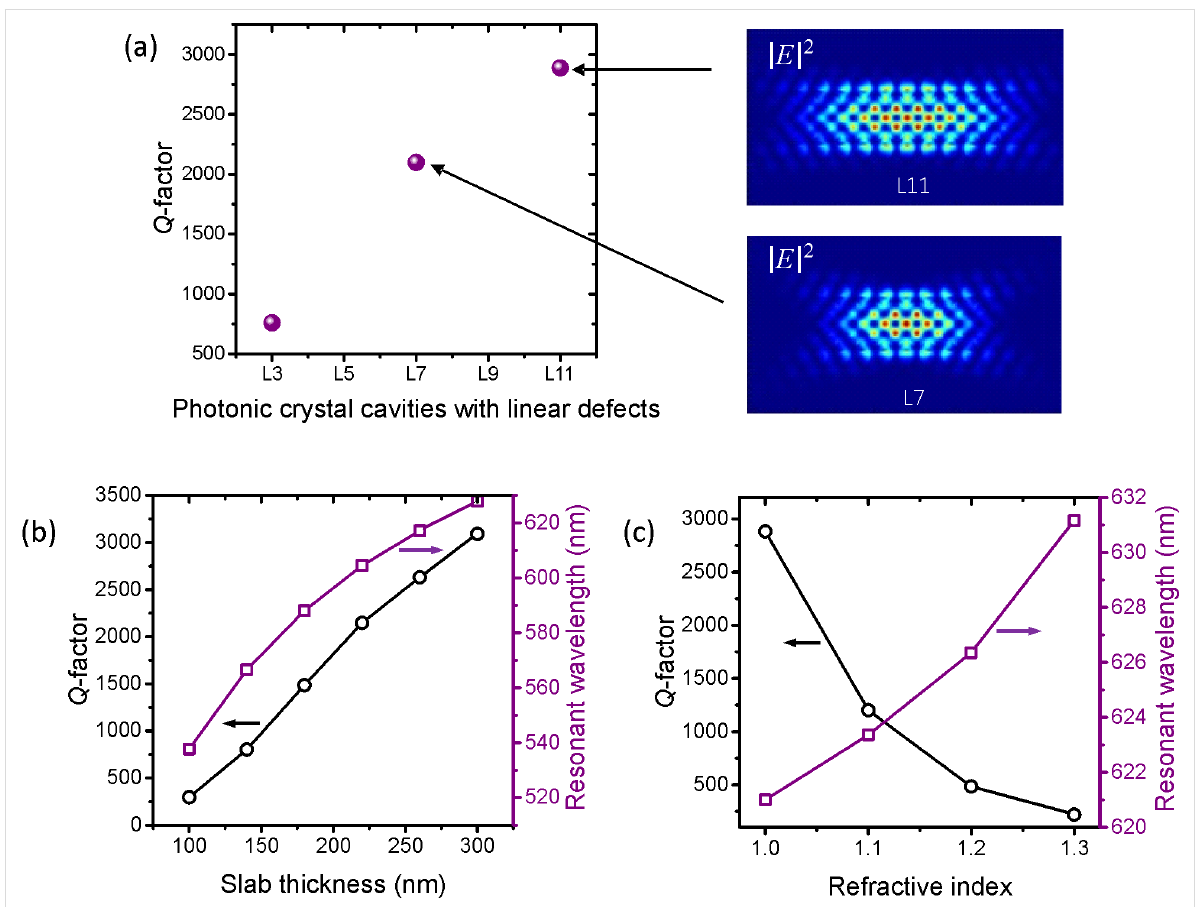
Figure 2: (a) Q -factors of various 2D photonic crystal cavities with an increasing number of linear defects, and the electric field intensity profiles of L7 and L11 cavities. Q -factor and resonant wavelength plotted as a function of (b) the slab thickness and (c) the refractive index of an underlying sub-